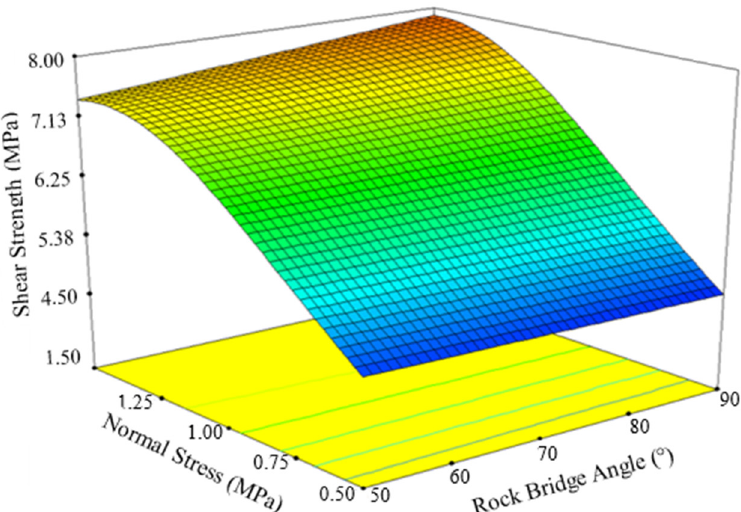
Figure 14. The RSM result for impacting γ on the shear strength of noncoplanar pre-cracked samples.